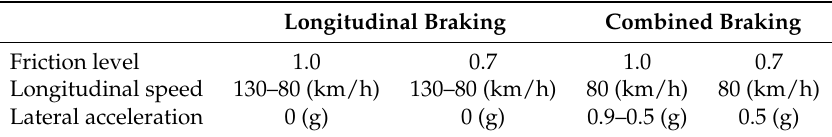
Table 2. Manoeuvres’